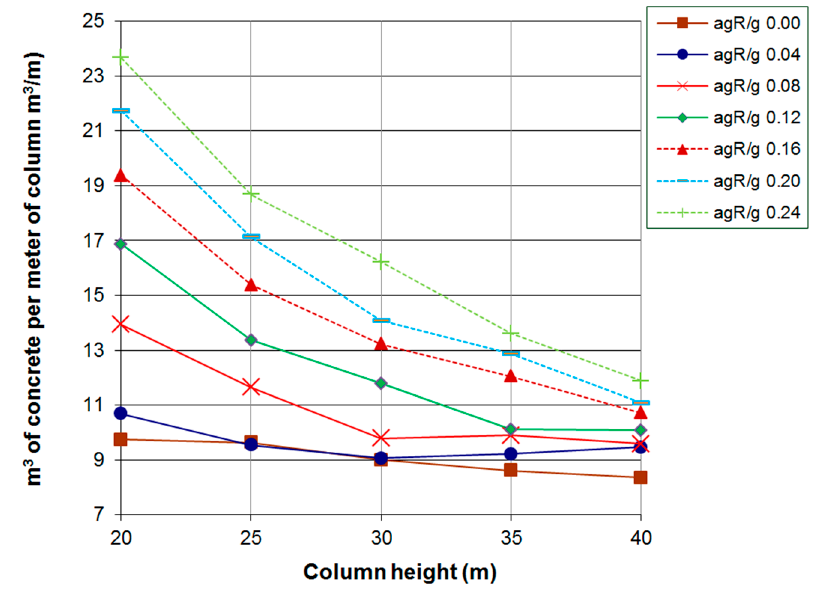
Figure 16. Water tank volume of concrete per unit height of the column.